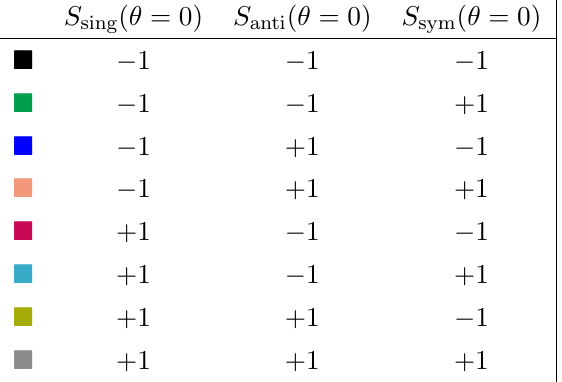
Table 1 . Colors assigned to the eight di(cid:11)erent combinations of S a ( (cid:18) = 0) = (cid:6) 1 which help characterize the faces and edges of the monolith as in (cid:12)gures 6 and